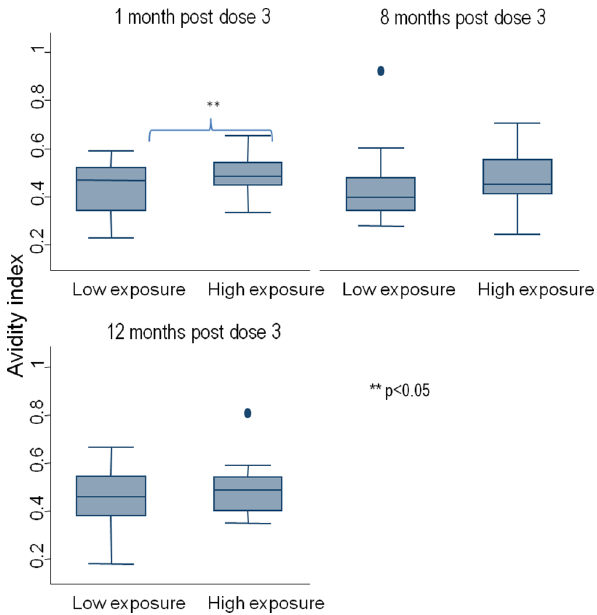
Fig. 2. Box plot of anti-CS antibody avidity by level of malaria exposure (based on malaria exposure index) at 1, , 8 and 12 months post dose 3.